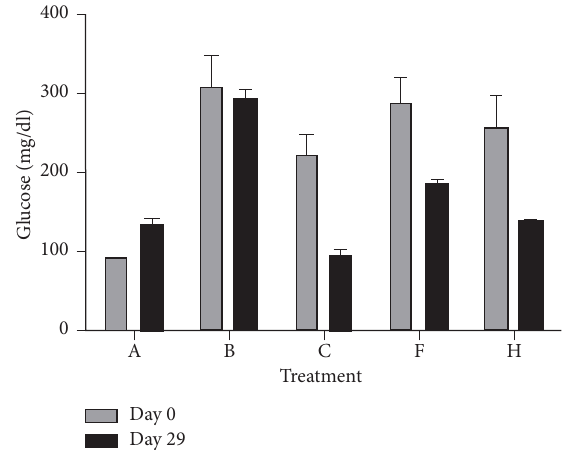
Figure 2: Efect of the K. senegalensis and A. indica hydroethanolic extracts on the blood glucose concentration of the diabetic rats. Results expressed as mean ± SD, n � 3 (with 95% confdence in- terval); A: normal control; B: diabetic control; C: glibenclamide;